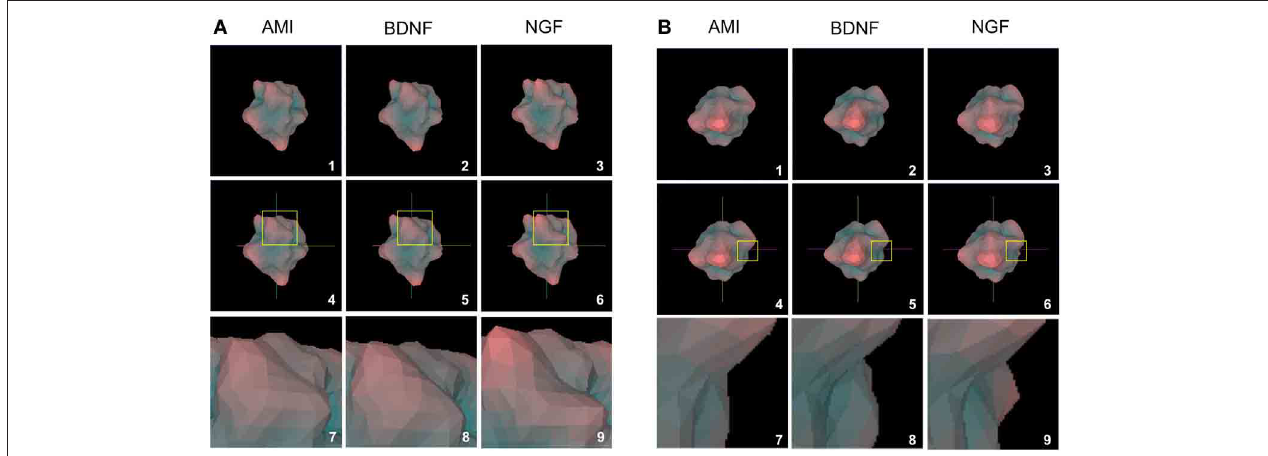
FIGURE 7 | Structural analogy between AMI and BDNF plurigons. (A) Panels 1, 2, and 3 depict representative plurigons for AMI-, BDNF- and NGF-stimulated transcriptomic datasets. Panels 4–6 depict the coordinate locations for plurigons in panels 1–3. In each plurigon window (4–6) a region of structural divergence between the plurigon structures in